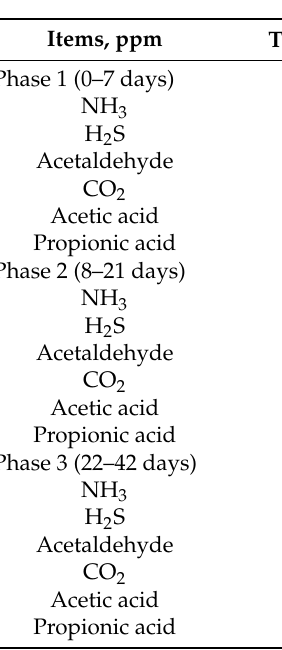
Table 5. Effect of blood plasma and yeast supplementation on the gas emission of weaning pigs 1 .